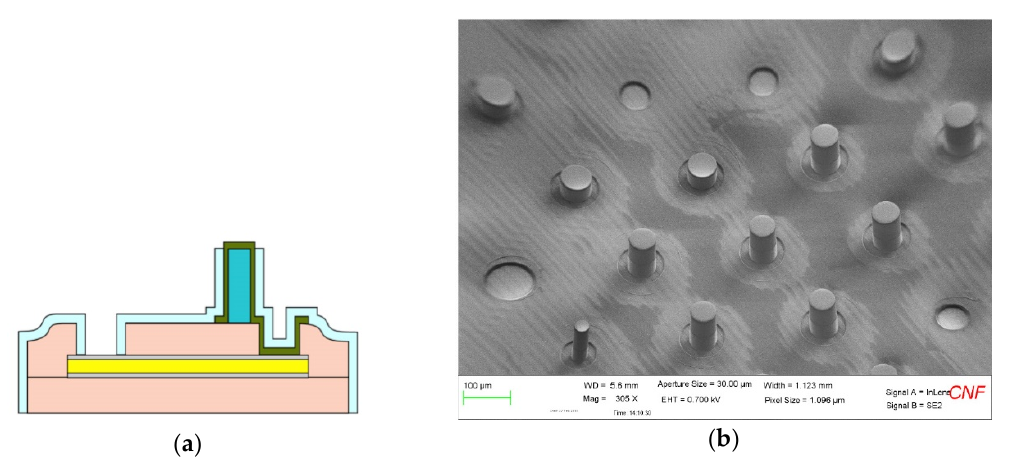
Figure 7. ( a ) A cross section diagram of a flexible, microfabricated electrode array with a penetrating post